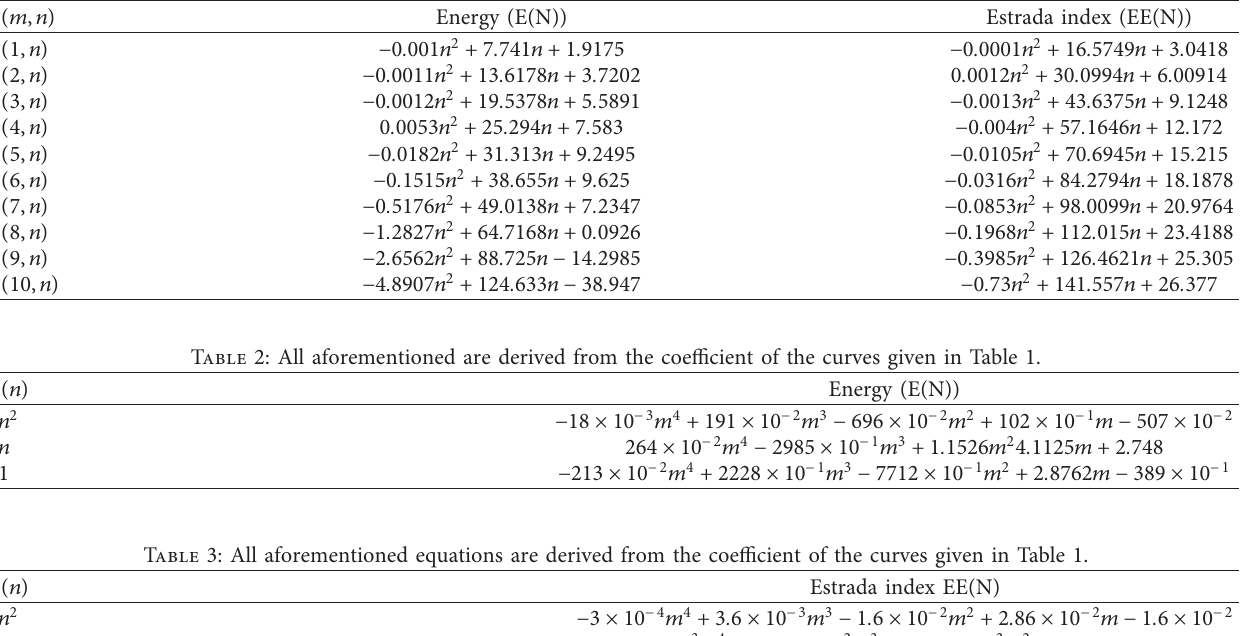
Table 1: The quadratic equation for the E ( N ) and EE ( G ) of TUC